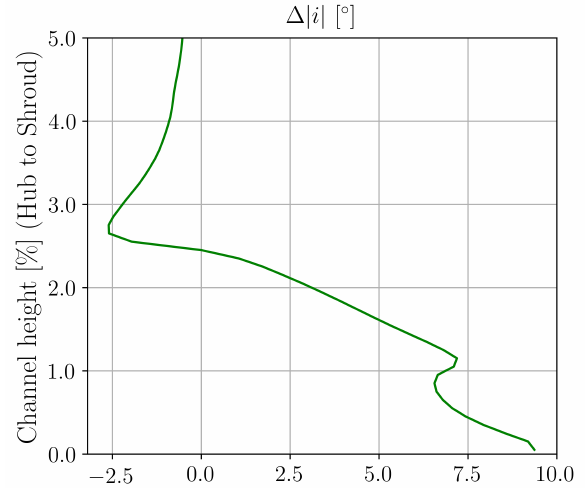
Figure 11. Improvement in incidence at diffuser vane leading edge at near stability limit operating point at Mu 2 =